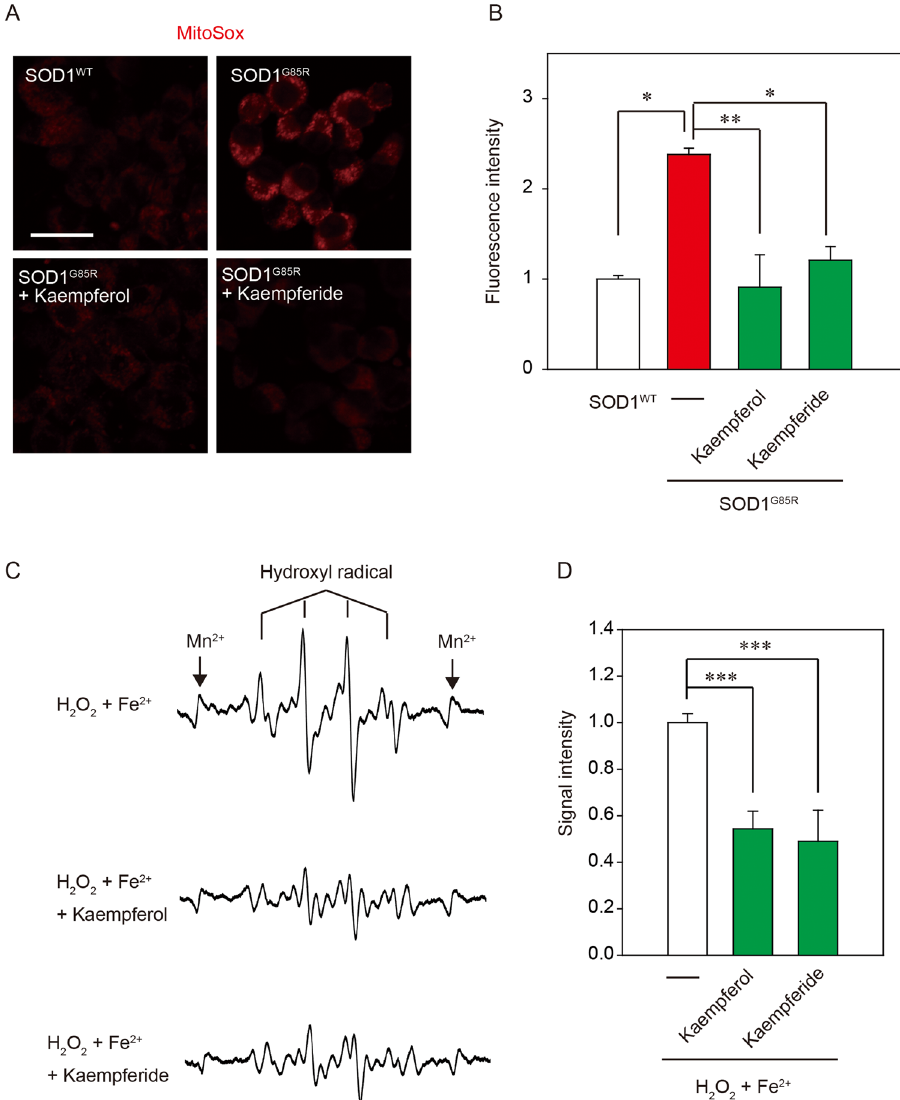
Figure 4. Both kaempferol and kaempferide suppressed SOD1 G85R -induced superoxide in mitochondria. ( A ) N2a cells expressing mCherry-SOD1 G85R were treated with 3 µ M kaempferol or 15 µ M kaempferide for 24 h. Subsequently, MitoSOX ® Red was added to the cell culture to a final concentration of 5 μ M to the cells and incubated for 30 min at 37 °C. ( B ) The relative fluorescence intensity was quantified by computerized image analysis with ImageJ. Data are expressed as mean ± S.E.M from three independent experiment, based on the fluorescence intensity of SOD1 WT . ( C ) Traces show typical spectra of DMPO-OH spin adducts generated from H 2 O 2 plus Fe 2 + in the absence (control) or presence of kaempferol and kaempferide. ( D ) The amount of • OH was semi-quantitatively measured as the formation of DMPO-OH spin adducts by ESR spectrometry. Data is expressed as the mean ± S.E.M of three determinations, based on control. * p < 0.05; ** p < 0.01. *** p < 0.001. Scale bar: 50 µ